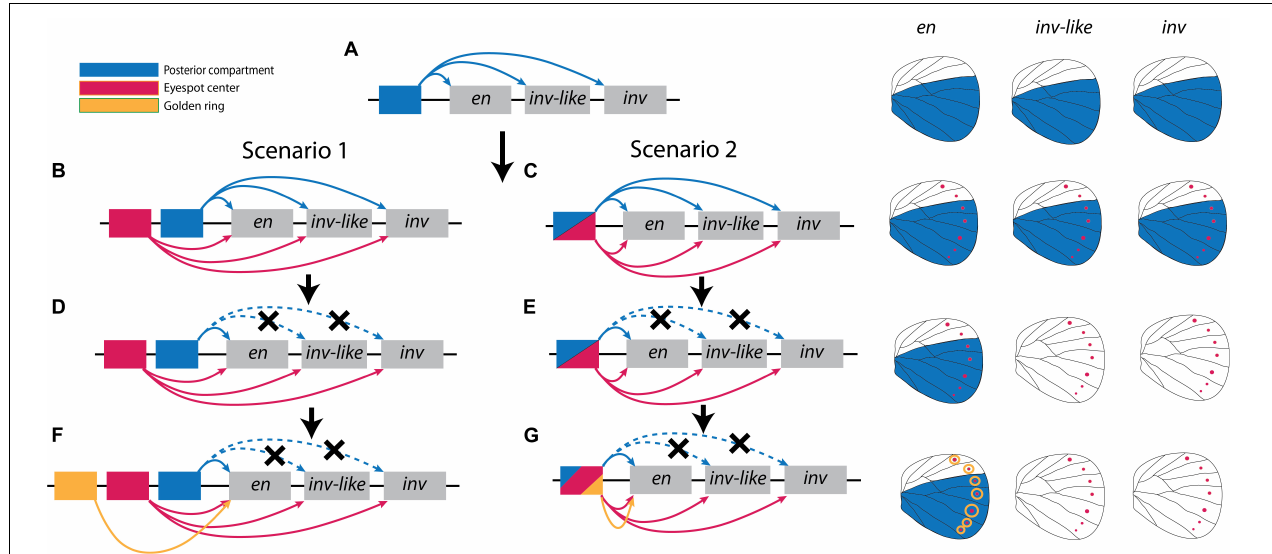
FIGURE 4 | Two alternative scenarios for the evolution of expression patterns of en -family genes. (A) The ancestral state of all the three en -family genes likely had a common cis -regulatory element that derived expression of all three paralogs in the posterior compartment. (B,D,F) Under Scenario 1, gain of novel cis -regulatory elements in the eyespot centers and in the golden rings resulted in the final patterns of gene expression we observe today. (C,E,G) Under scenario 2, the same (or a restricted number) of ancestral cis -regulatory elements become redeployed to drive the novel patterns of gene expression in the eyespot centers and in the golden